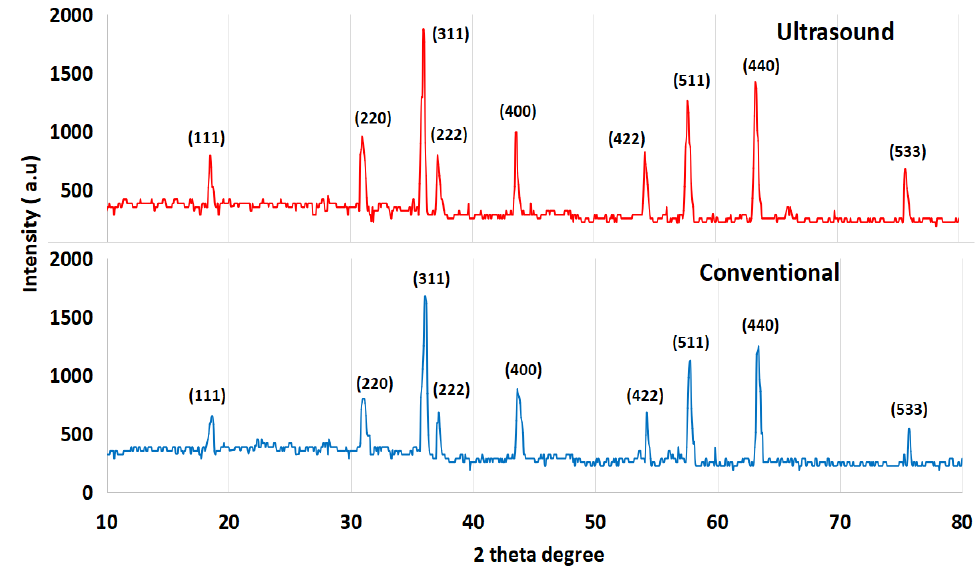
Figure 2. XRD spectrum of ultrasonically prepared and conventionally prepared NiFe 2 O 4 catalysts at 5 wt% Ni loading.